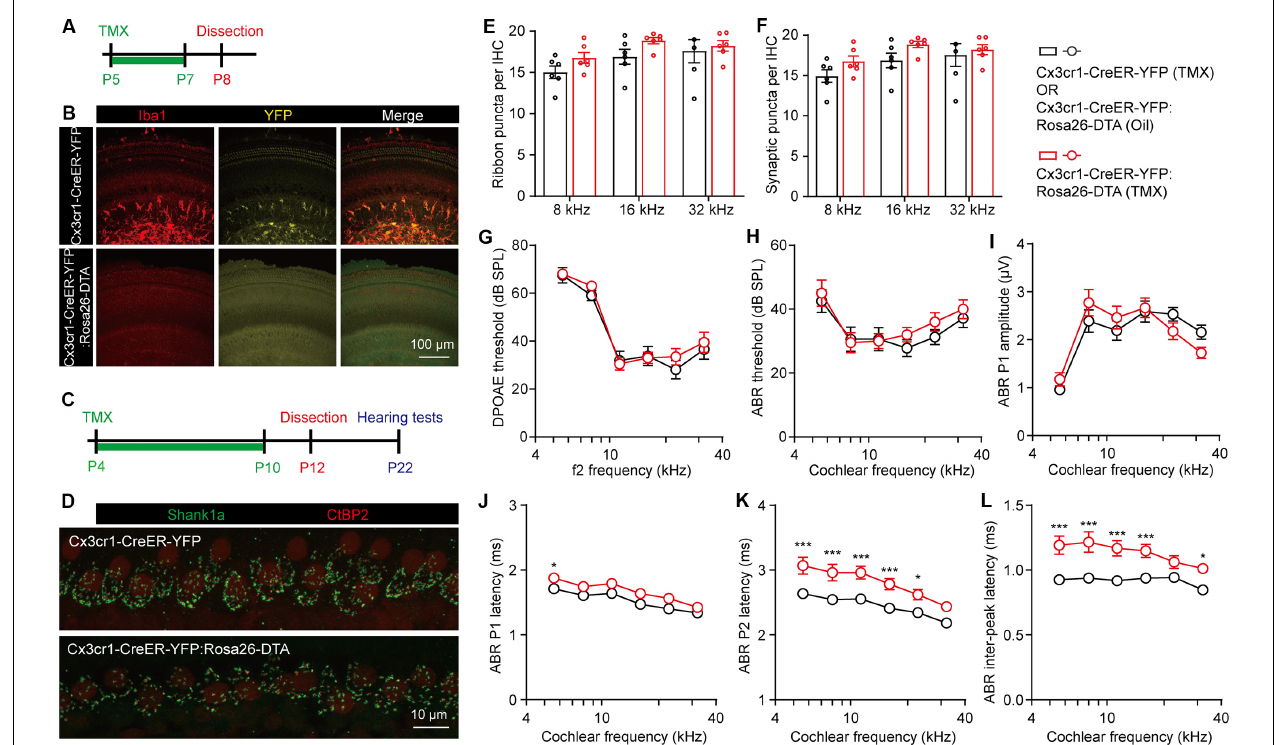
FIGURE 4 | Temporary complete elimination of postnatal macrophages did not affect ribbon synapses pruning and auditory function. (A,B) Schematic diagram (A) and confocal images (B) showing conditional elimination of postnatal macrophages in Cx3cr1-CreER-YFP:Rosa26-DTA (macrophage-deficient) cochleae at 16 kHz region. (C,D) Schematic diagram (C) and confocal images (D) showing effects of postnatal macrophage elimination on cochlear ribbon synapses. Presynaptic ribbons and postsynaptic structures on P12 mice at 16 kHz were immunolabeled with CtBP2 (red) and Shank1a (green), respectively. (E,F) Quantitative analyses of IHC synaptic ribbons (E) and putative ribbon synapses (F) in P12 control and macrophage-deficient cochleae. N = 4–6, error bars represent mean ± SEM. (G–L) DPOAE thresholds (G) , ABR thresholds (H) , ABR P1 amplitudes (I) , ABR P1 latencies (J) , ABR P2 latencies (K) , and ABR P1-P2 inter-peak latencies (L) of P22 control and macrophage-deficient mice. Cx3cr1-CreER-YFP:Rosa26-DTA mice were injected with tamoxifen (TMX) from P4 to P10. Controls mice were either Cx3cr1-CreER-YFP mice injected with TMX or Cx3cr1-CreER-YFP:Rosa26-DTA injected with corn oil. N = 10 (TMX) or 16 (corn oil), error bars represent mean ± SEM. * p < 0.05 and *** p < 0.001 by two-way ANOVA.